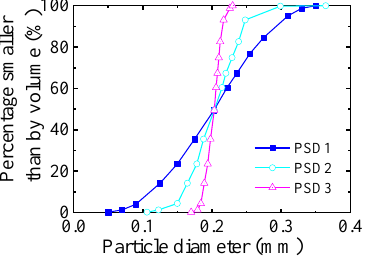
Fig. 1. Particle size distributions used in the simulations.